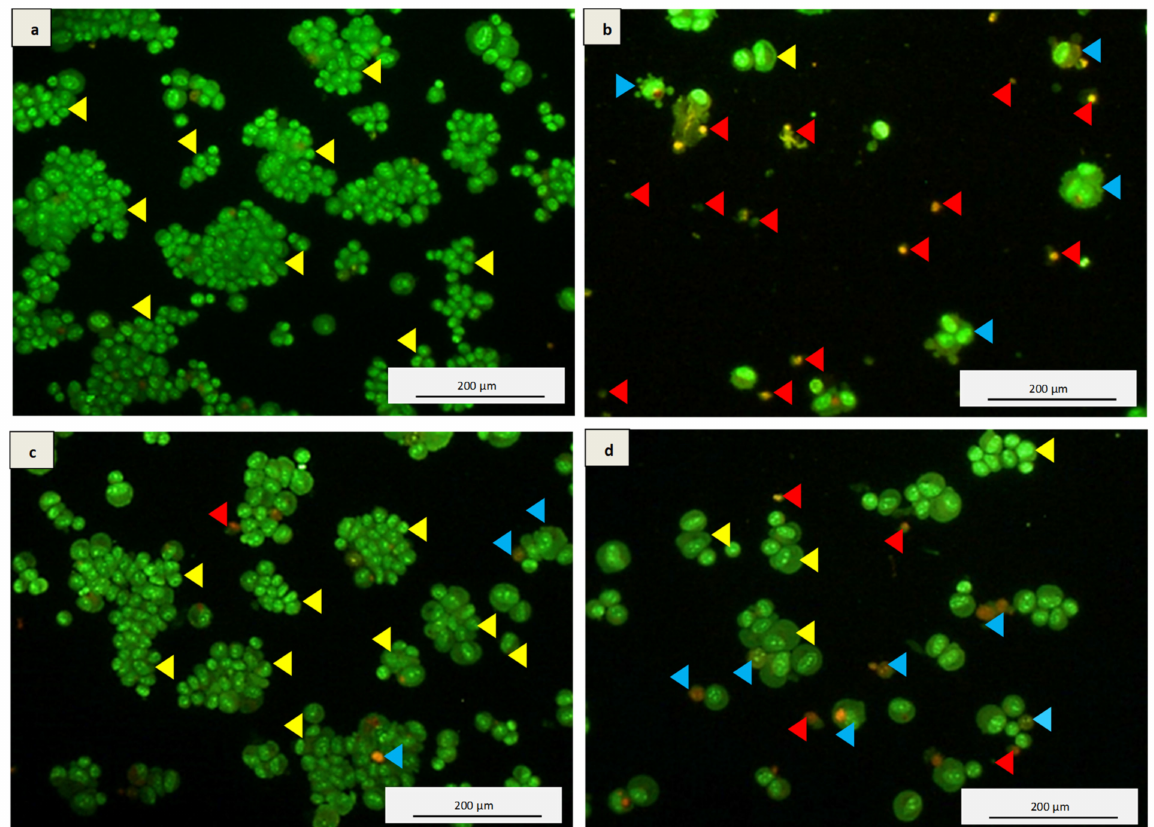
Figure 4. Micrographs of acridine orange (AO, green) and propidium iodide (PI, red) double staining on differentiated SH-SY5Y cells. ( a ) Untreated differentiated SH-SY5Y cells, ( b ) SH-SY5Y cells challenged with H 2 O 2 for 24 h, ( c ) 48 h Kefir B pre-treated plus 24 h H 2 O 2 -exposed SH-SY5Y cells, ( d ) 48 h Kefir C pre-treated plus 24 h H 2 O 2 -exposed SH-SY5Y cells (yellow arrowhead: viable; blue arrowhead: apoptosis; red arrowhead: necrosis). The images were taken independently in multiple times, and 40x magnification was